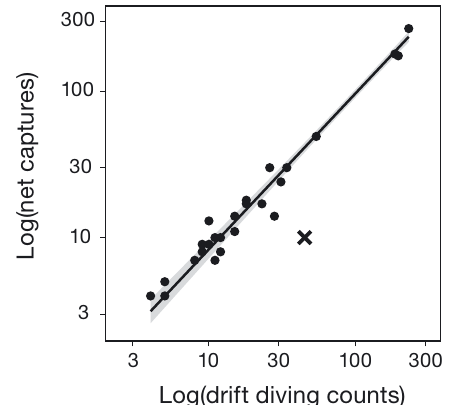
Fig. 3. Generalized linear regression of the total Atlantic salmon counts observed in drift diving and net captures. Solid line: fitted line; shaded area: 95% confidence intervals. The × is a point that was removed from the analysis due to an